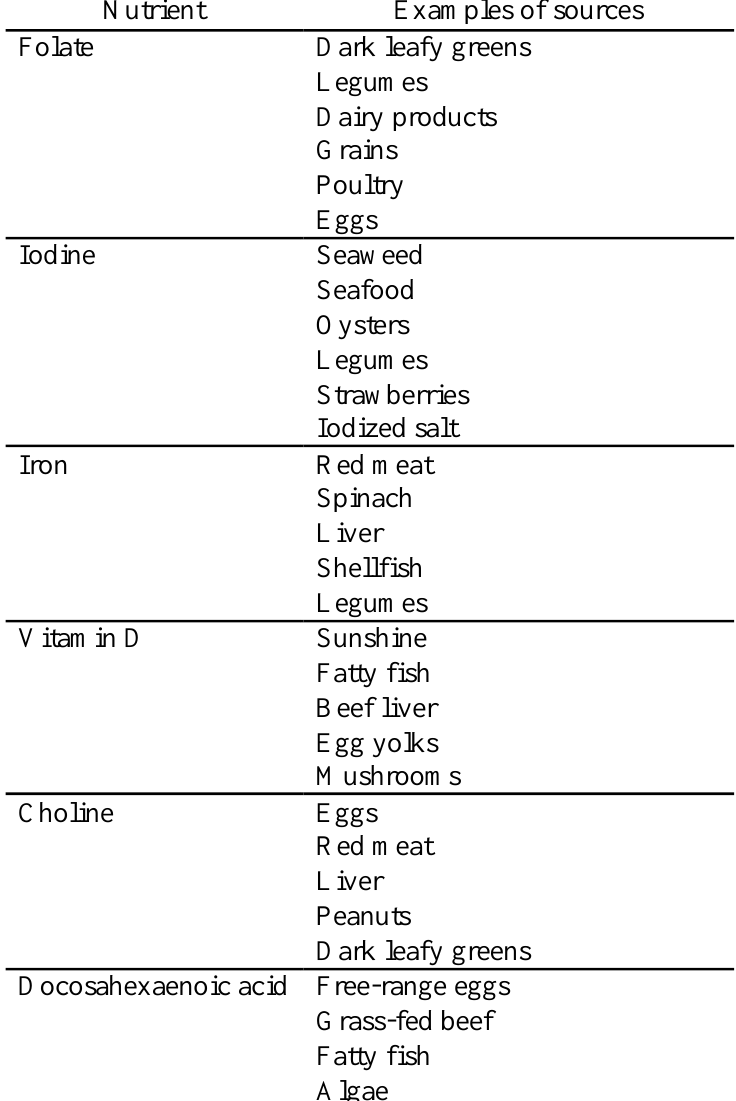
Table 2. Examples of natural sources of selected nutrients